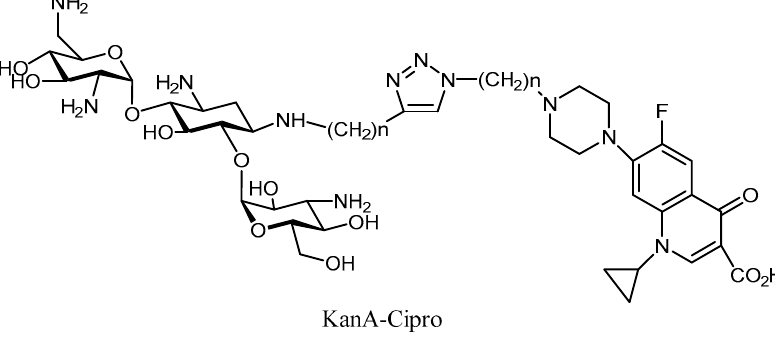
Figure 16. Structure of the kanamycin B-Cipro complex as hybrid antibiotic.